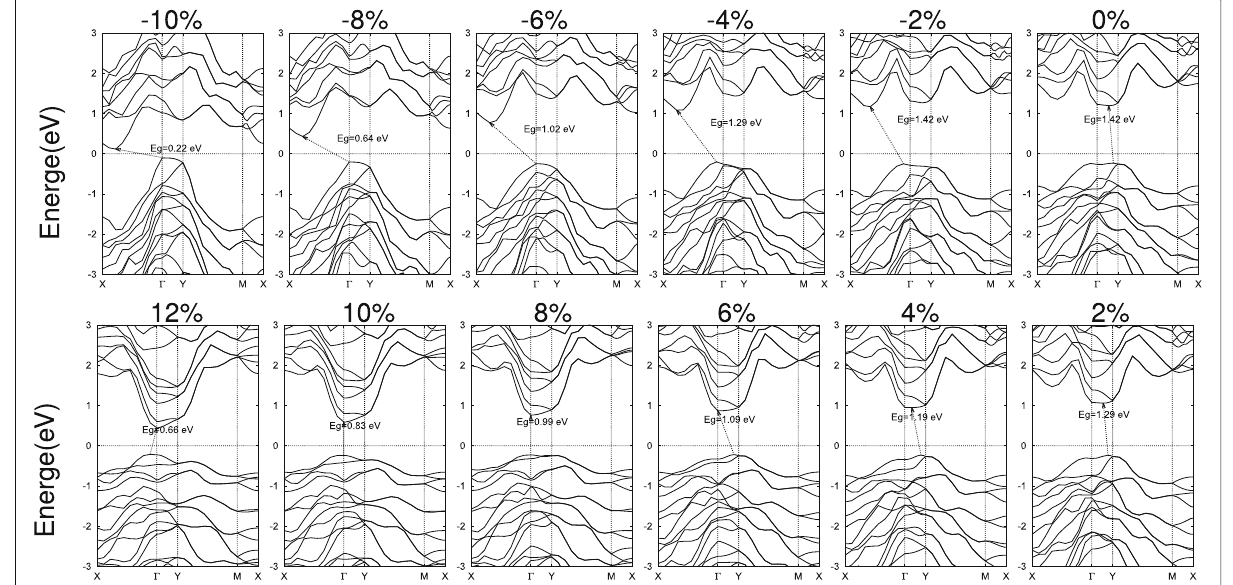
Fig. 7 Band structures of 2D SiAs 2 under the biaxial strains. The Fermi level is set as zero and indicated with a dot